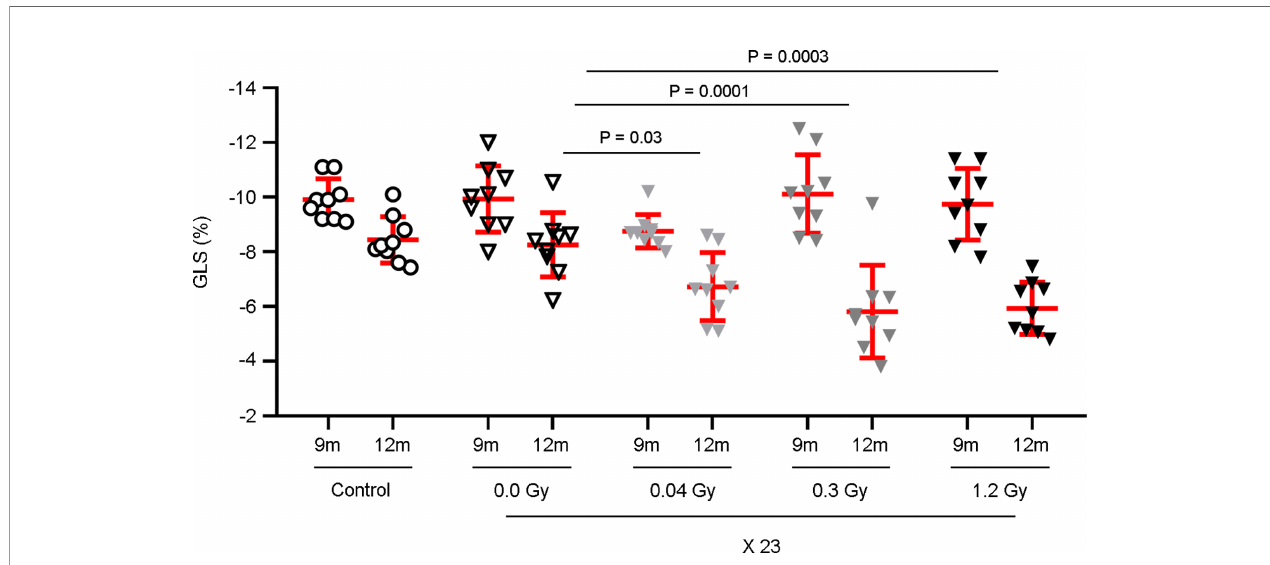
FIGURE 2 | GLS is signi fi cantly decreased by the cumulative doses of 0.92, 6.9, and 27.6 Gy. Rat hearts were sham-irradiated or irradiated with 0.04, 0.3, and 1.2 Gy for 23 days. Rats, neither irradiated nor anesthetized, were used as controls. Echocardiography was performed at 9 and 12 months after the end of IR exposure. Measurements of the GLS show a signi fi cant decrease only at 12 months, with the daily doses of 0.04, 0.3, and 1.2 Gy. Individual data and mean ± SD (in red) are shown from n = 9 rats per group. Between-group changes were assessed by two-way repeated measurements ANOVA followed by a Bonferroni post-hoc test with a between-subject factor of irradiation, relative to the 0.0 Gy experimental group; signi fi cant P- values are